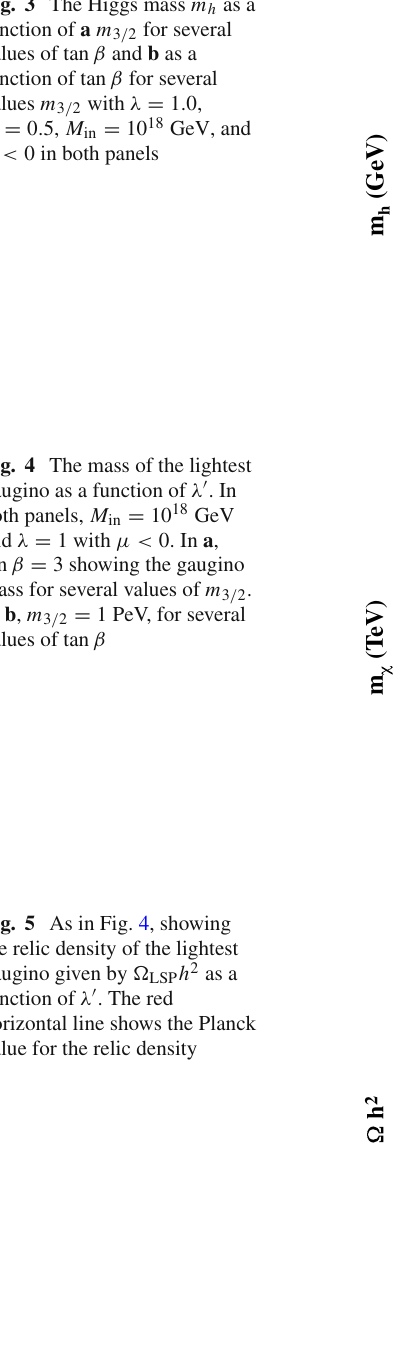
blue shaded strip corresponds to the region where the relic density falls within 3 σ of the central value determined by Planck [60], which crosses the m h = 125 GeV contour at λ ≈ 0 . 75. We can compare the position of the endpoint of the relic density strip with λ = 1 with the result in Fig. 5a where we see that the horizontal line would be crossed by a contour with m 3 / 2 between 200 and 300 TeV in agreement with the endpoint in this